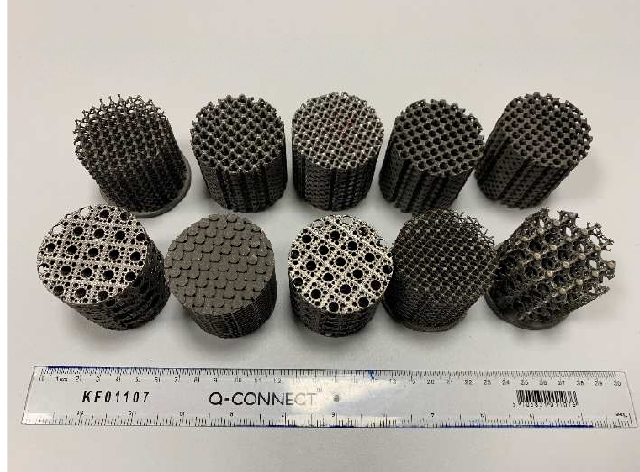
Figure 2. Various cellular concept cubes made from Ti-64 alloy.